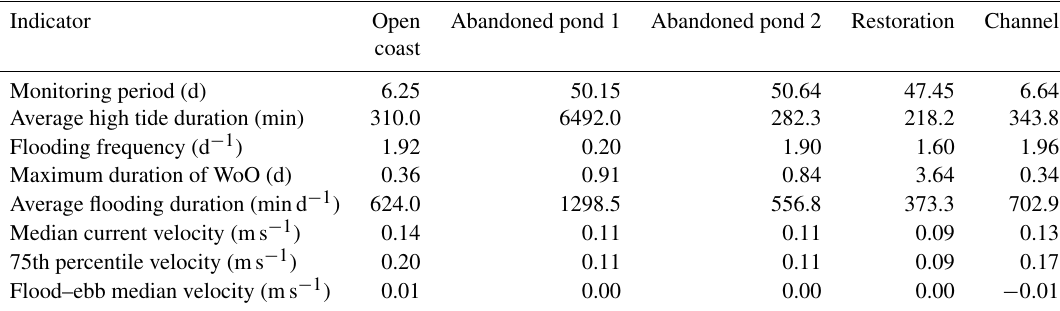
Figure 5. (a) Summary of predicted median current velocities and inundation duration for the entire monitoring duration (based on 1min aggregated data) along the elevational gradient of the terraced salt marsh at the Bay of Fundy. (b) Inundation duration (mind − 1 ) at the logger locations at the North Sumatra field site. Table 1. Summary of site characteristics in North Sumatra using the Mini Buoy and the R shiny application. Note that “Abandoned pond 2” corresponds with the long-term location, and “Channel” corresponds with B1 in Fig. 2. Only “Open coast” and “Channel” show current velocities above the detection threshold. At the Abandoned pond 1 site a sluice system was partially in operation, leading to prolonged non-tidal